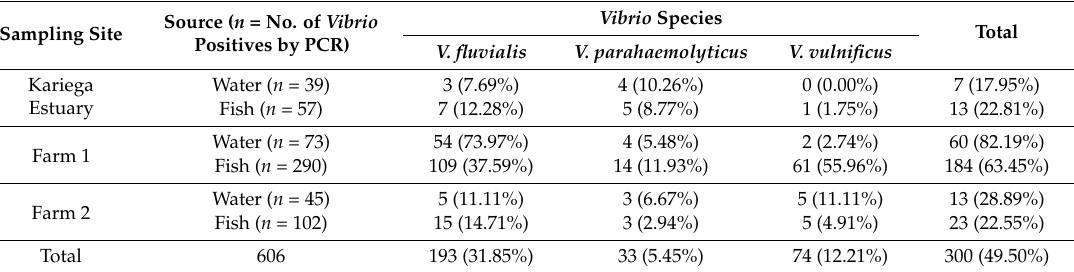
Figure 3. Representative gel showing the 217 bp PCR amplified V. fluvialis toxR gene. Lane 1: molecular weight marker (50 bp), lane 2: negative control, lane 3: positive control (ATCC 33809), lanes 4 and 5: negative isolates, lanes 6–12: positive isolates. Table 3. Distribution and frequency of occurrence of PCR confirmed Vibrio strains isolated from water and fish samples.